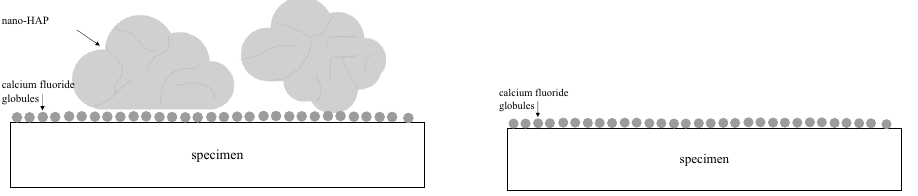
Figure 8. Schematic figure after primary fluoride application and subsequent nano-HAP application. Primary fluoridation does not compromise nano-HAP adsorption. Left: nano-HAP particles partially cover the calcium fluoride globules. Right: after spraying, nano-HAP particles are completely removed and a surface covered with calcium fluoride globules remains. Nano-HAP hydroxyapatite nanoparticles.